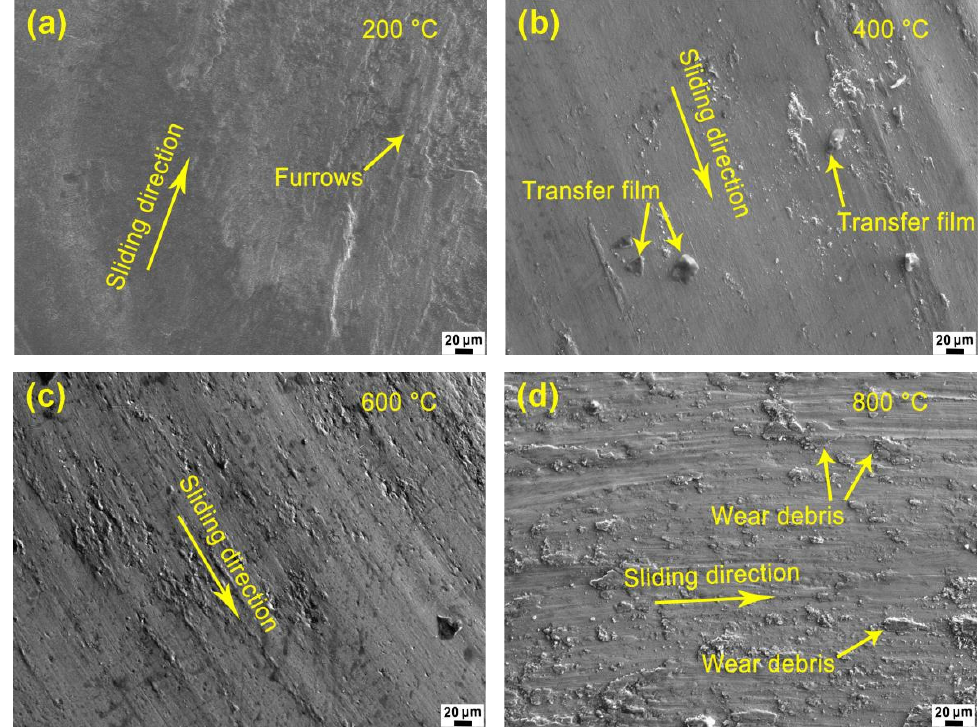
Figure 9. Typical worn surface morphologies of Si 3 N 4 balls against the NST at 200 ( a ), 400 ( b ), 600 ( c ) and 800 °C ( d ) .